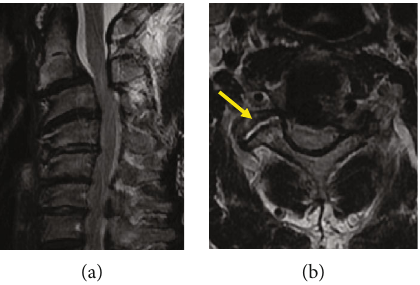
Figure 1: Preoperative X-ray. Axis slipped anteriorly by 7mm. No change in slippage was observed in the fl exion and extension positions.